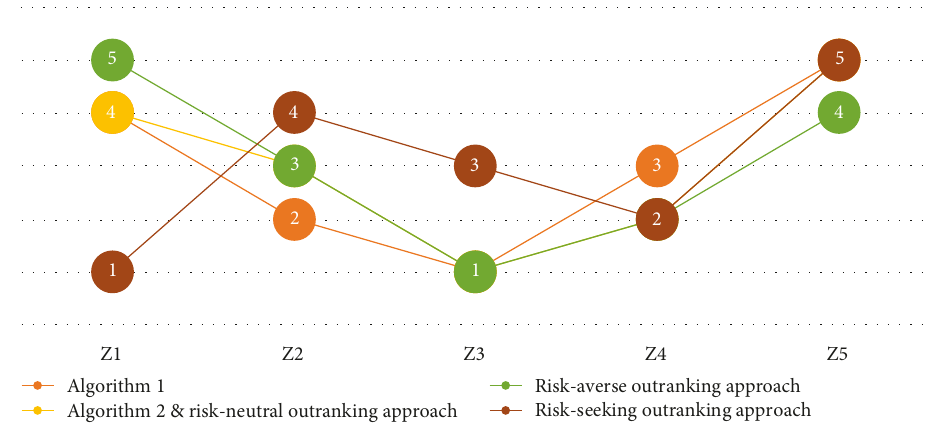
Algorithm 1 Algorithm 2 & risk-neutral outranking approach Figure 4: Contrast of ultimate priority rankings in the fi nancing decision